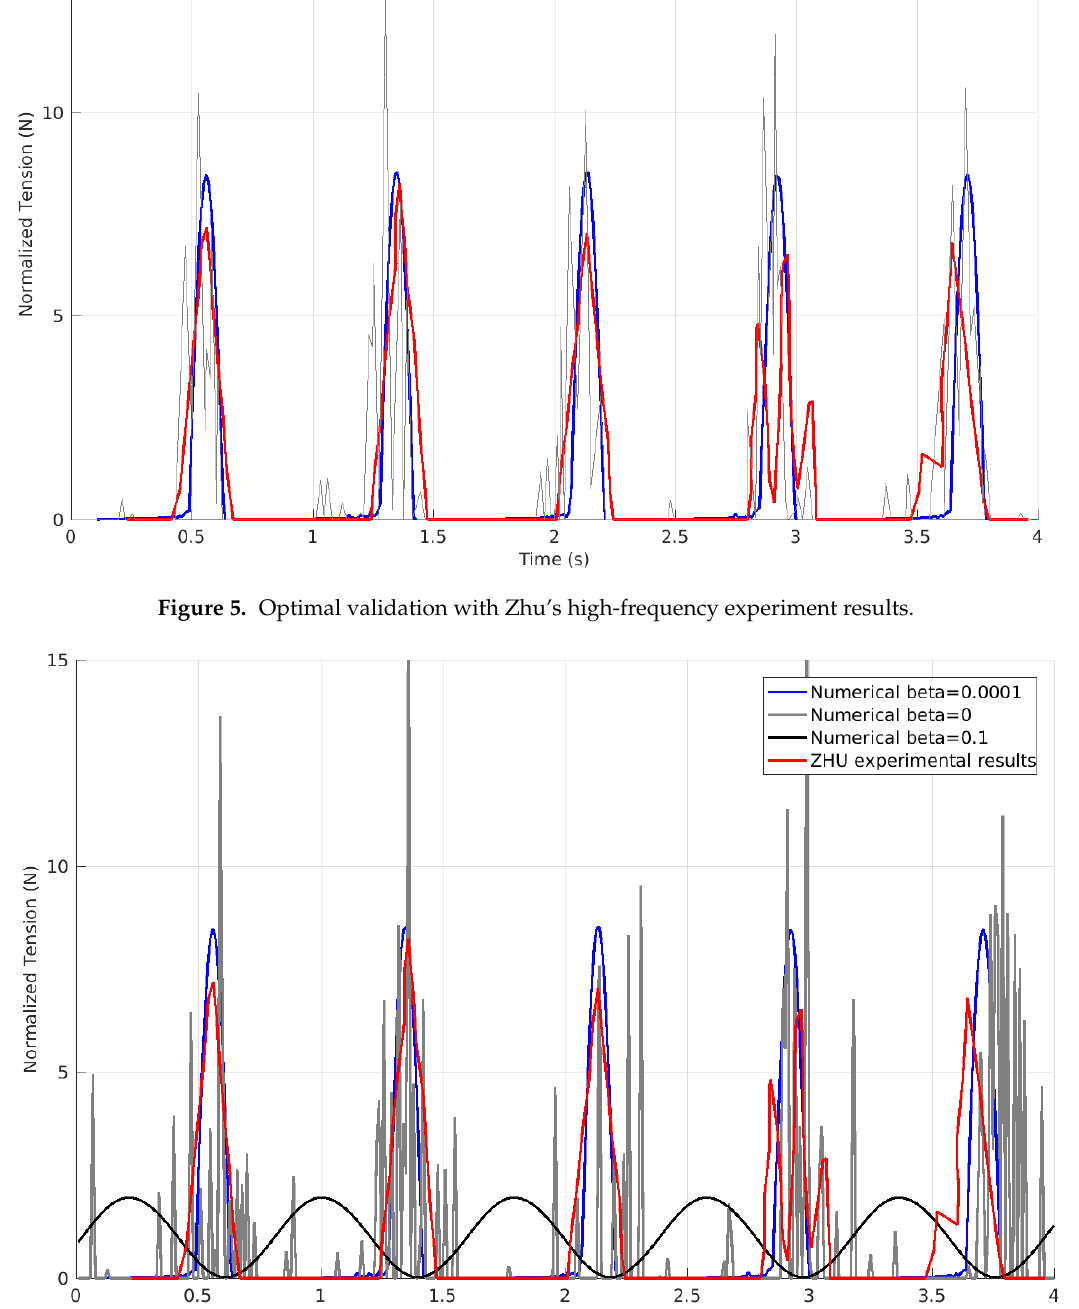
Figure 6. Numerical results for different β -values compared with experimental